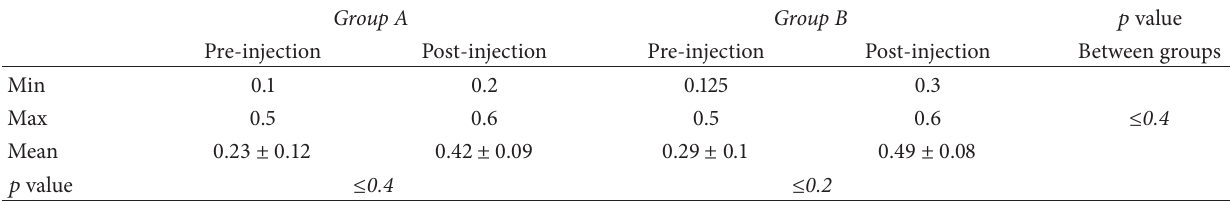
Table 1: The pre- & post-injection improvement of